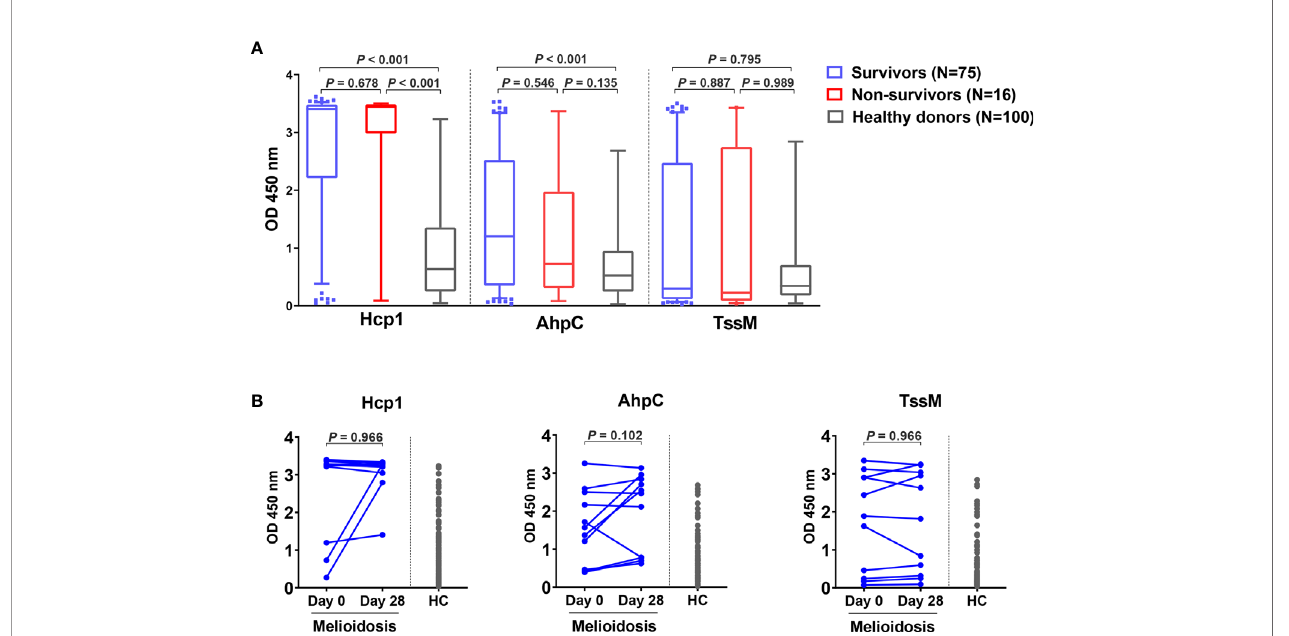
FIGURE 5 | Antibody responses to Hcp1, AhpC and TssM in healthy donors and melioidosis patients. (A) IgG-speci fi c responses are shown for acute melioidosis patients and healthy donors. Box plots represent 25 th and 75 th percentile boundaries in the box with the median line within the box; the whiskers indicate the 10 th and 90 th percentiles. P-values were calculated using the Mann-Whitney test. (B) IgG-speci fi c responses of 11 melioidosis patients at day 0, day 28 and healthy donor controls (HC). Statistical signi fi cance between time points within a group were determined using the paired Wilcoxon